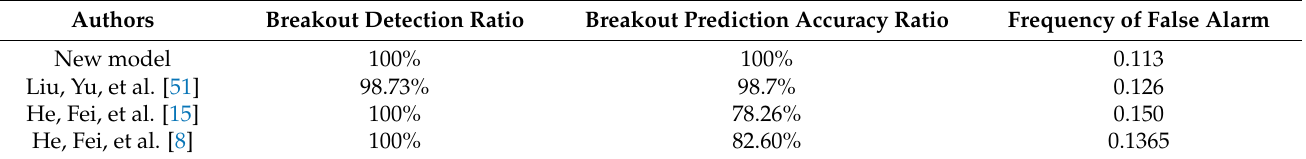
Table 5. Compare the results obtained by the new model with the data of other researchers.